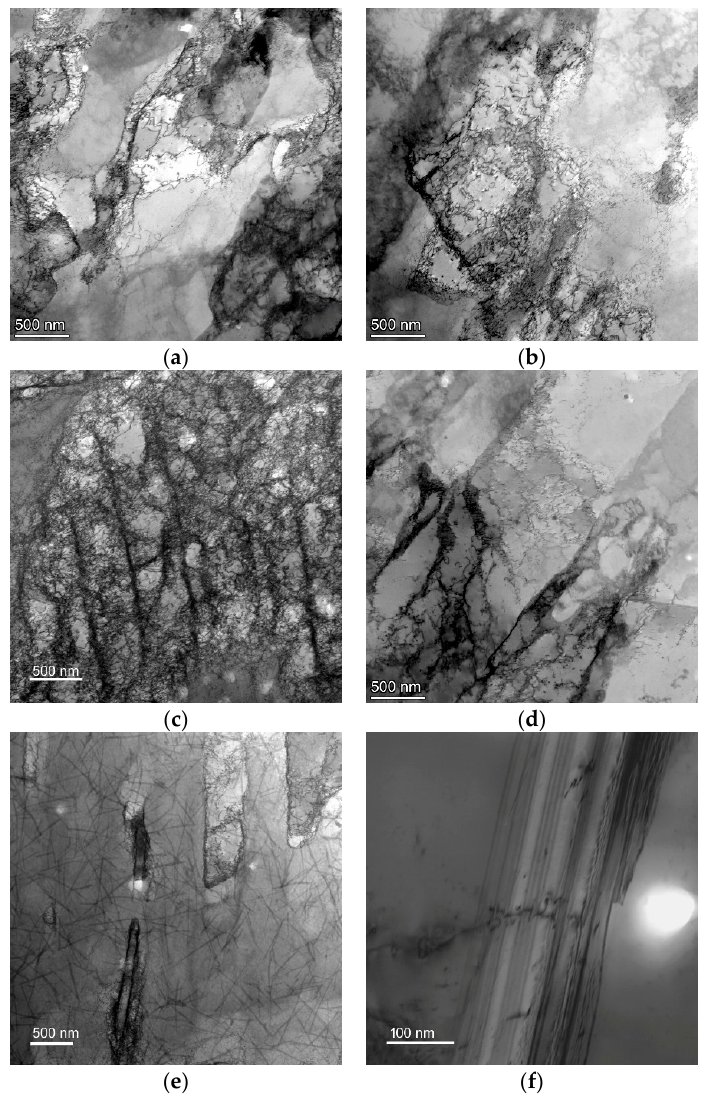
Figure 3. TEM substructure images for RT360 specimen periphery ( a ); RT360 specimen axis ( b ); CR180 specimen periphery ( c ); CR180 specimen axis ( d ); (nano)twinning within the CR180 specimen ( e , f ).